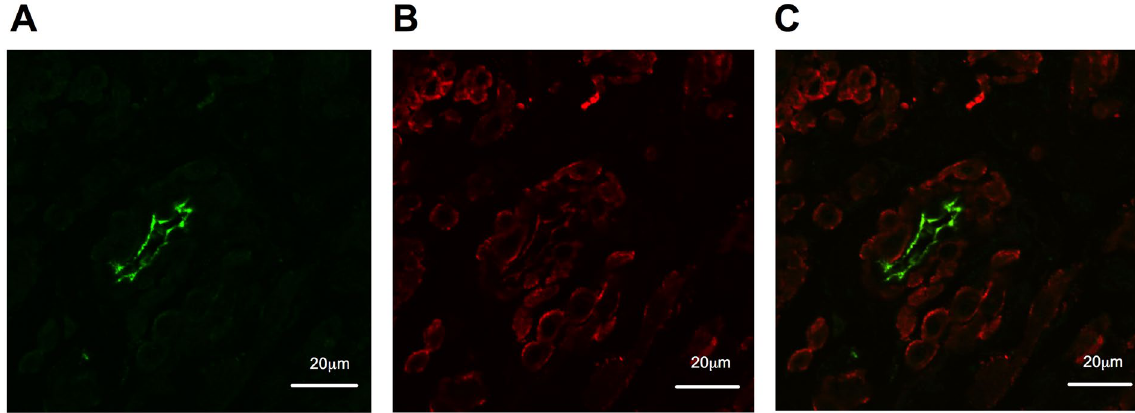
Figure 3. Immunofluorescence staining for K Ca 2.3 channels in K Ca 2.3 T/T ( + Dox) mouse corpus cavernosum. ( A ) Immunofluorescence for K Ca 2.3 expression. ( B ) Immunofluorescence image of smooth muscle actin expression. ( C ) Merged